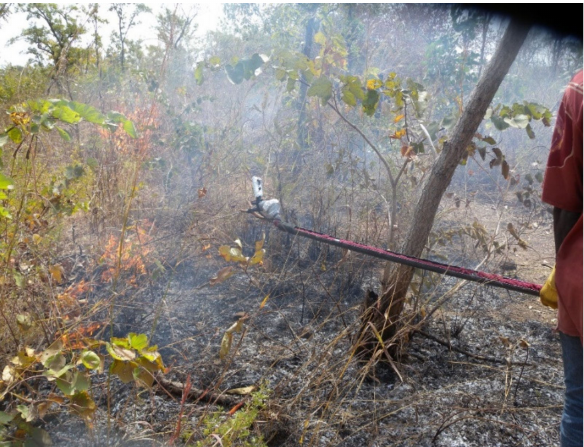
Figure 7. Collecting emissions data using a long nozzle on an IMR 1400 gas analyzer from a low- intensity backfire in the village of Tabou (Photograph by P.